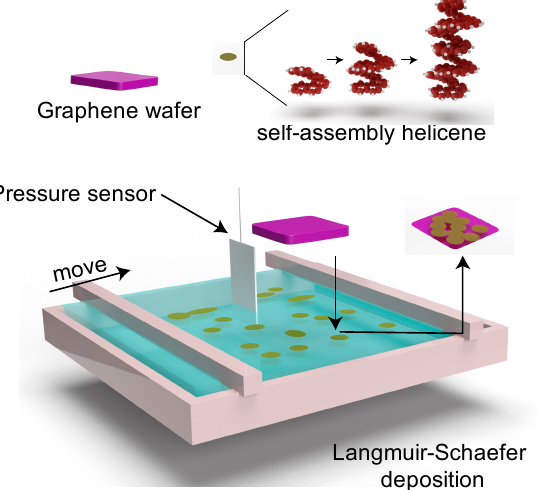
Figure 1. Illustration of the Langmuir-Schaefer deposition process of helicene on graphene. The surface pressure was measured using the Wilhelmy plate method with a disposable paper plate.